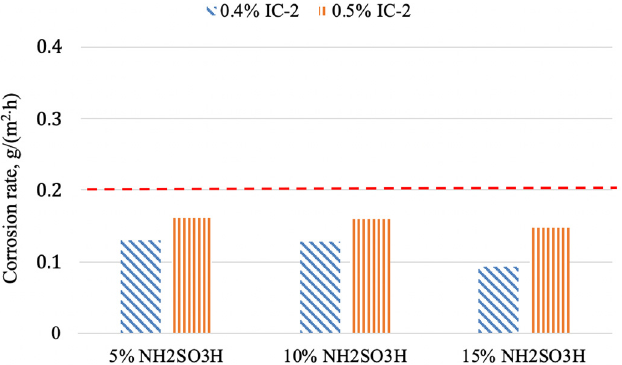
Figure 3. Corrosion rate of steel St3 in aqueous solutions of NH 2 SO 3 H of various concentrations with the addition of corrosion inhibitor IC-2, τ = 24 h, t = 20 °C.